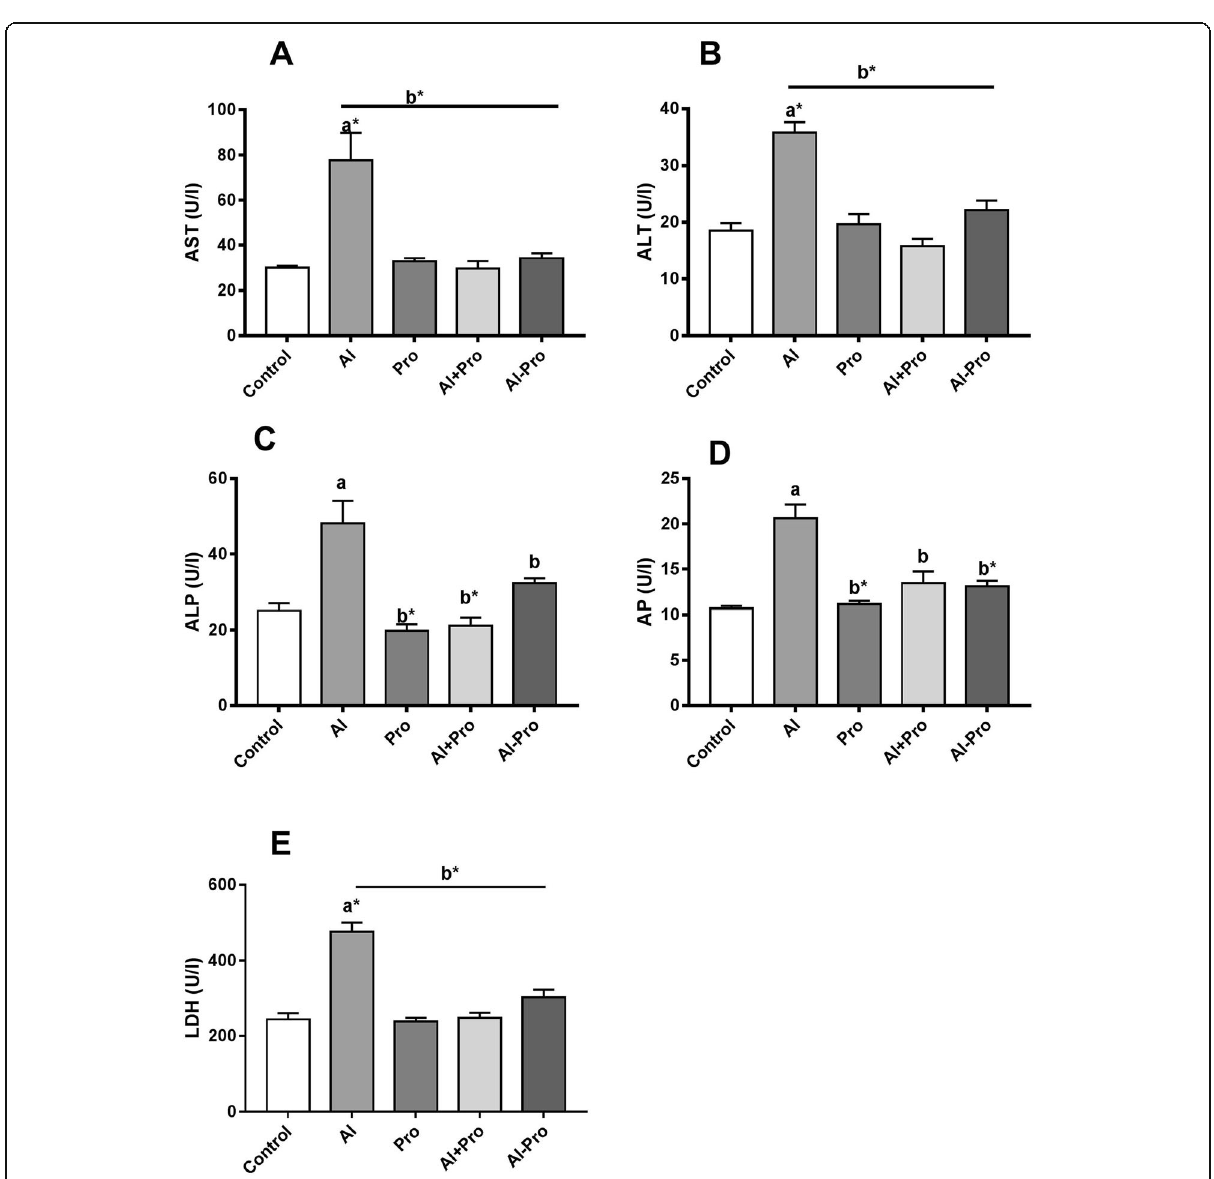
Fig. 3 Effect of propolis for two months on the plasma level of creatinine ( A ), uric acid ( B ), urea ( C ), cholesterol ( D ), and triglycerides ( E ) in rats treated with AlCl3. Significance (a): relative to the control group. Significance (b): relative to the AlC13 group. Significance: P < 0.05, highly significance (*): P <